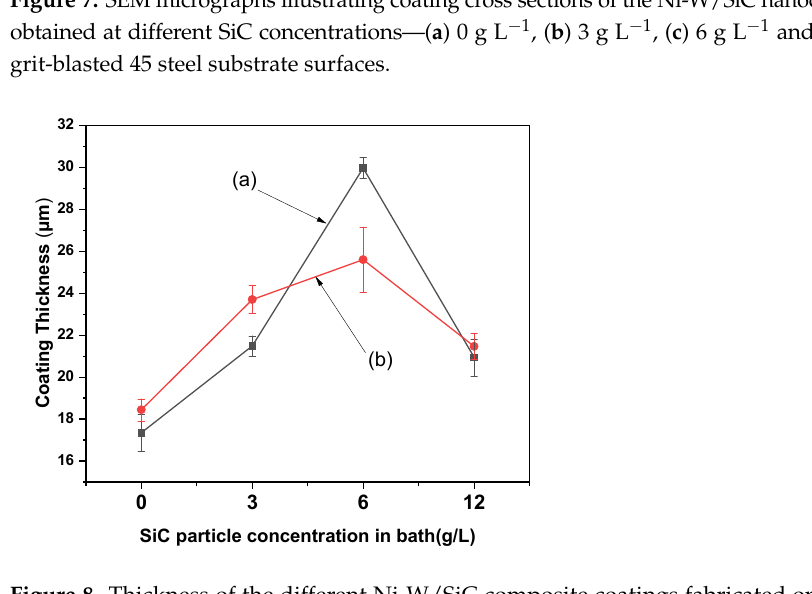
Figure 8. Thickness of the different Ni-W/SiC composite coatings fabricated on ( a ) polished and ( b ) grit-blasted 45 steel obtained at different SiC concentrations. Figure 9 presents the EDS spectrum of the Ni-W coatings pretreated by polishing: Ni-W(P); pretreated by grit blasting: Ni-W(GB) and Ni-W/SiC nanocomposite